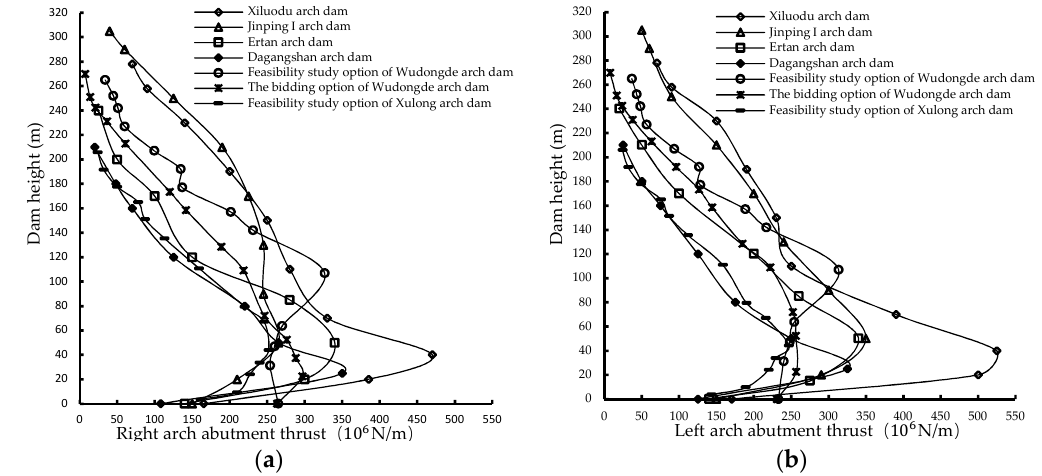
Figure 13. The distribution characteristics of arch thrust of several high arch dams. ( a ) Right arch abutment thrust; ( b ) left arch abutment thrust.